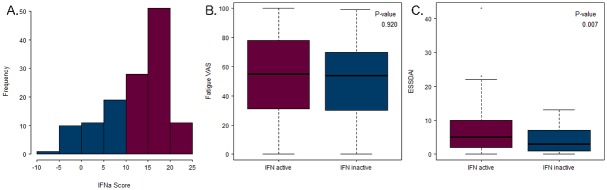
Interferon type I signature and fatigue.(A) The IFN score ranges for the 133 patients. (B) The Fatigue VAS scores for the IFN-active and IFN-inactive groups. (C) The ESSDAI scores for the IFN-active and IFN-inactive groups.